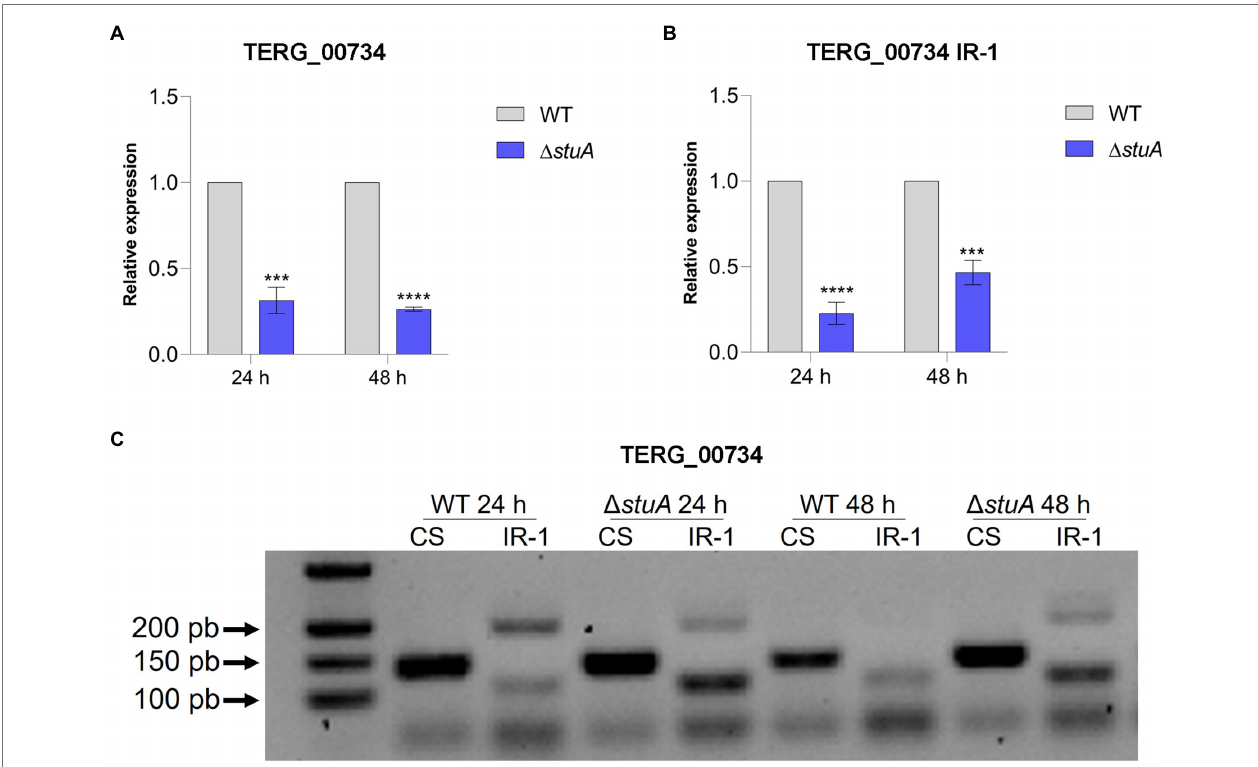
FIGURE 2 | (A) Relative expression of the CS isoforms of TERG_00734 with WT strain transcript levels as the reference. (B) Relative quantification of the IR isoforms of TERG_00734 considering CS isoform transcript levels of each strain as references. (C) CS and IR (intron 1 retention—IR-1) isoforms in agarose gel after conventional amplification using cDNA of each strain as template. Statistical analyses for transcript quantification experiments were carried out using unpaired t - tests, and statistical significance was determined by the Holm-Sidak method considering *** p < 0.001 and **** p <